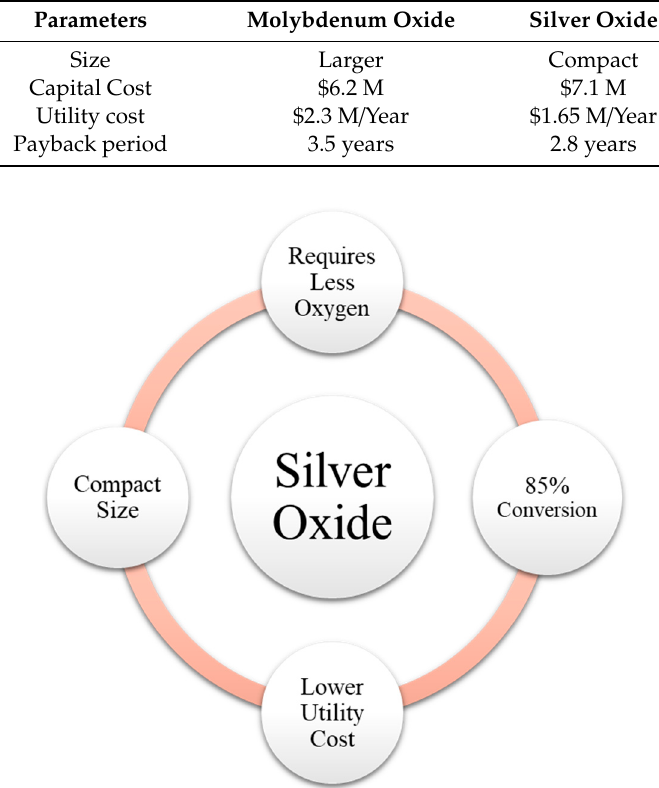
Figure 4. Silver oxide-based process.